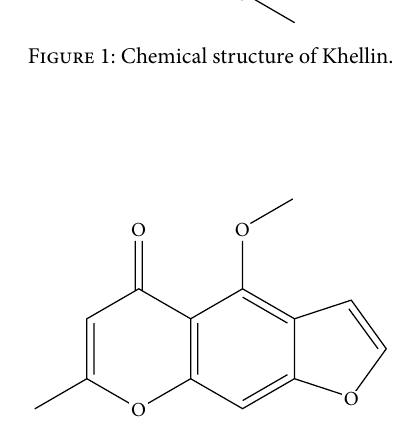
Figure 2: Chemical structure of